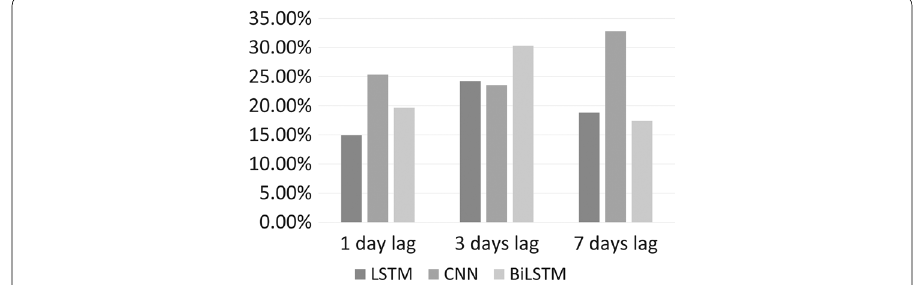
Fig. 10 Difference between maximum and lowest accuracy